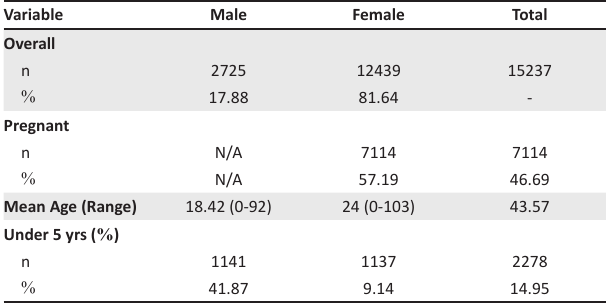
TABLE 2: Demographic data of patients served at the Tropical Laboratory Initiative, Tontokrom, Ghana, 2010–2017.